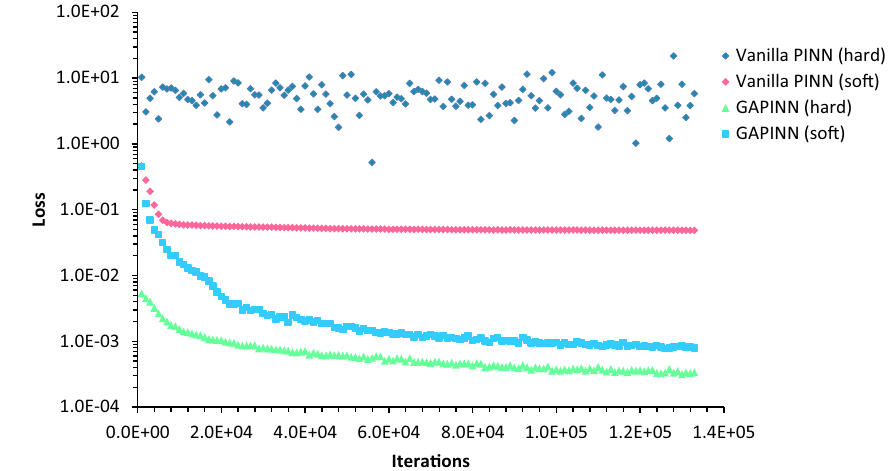
Fig. 7 Comparison of loss over epoch during the network training for both vanilla PINN and the proposed GAPINN using hard and soft constraints for generating surrogate models for solving Navier–Stokes equations on non‑parameterized geometries without the use of training data. Depicted is the error after each